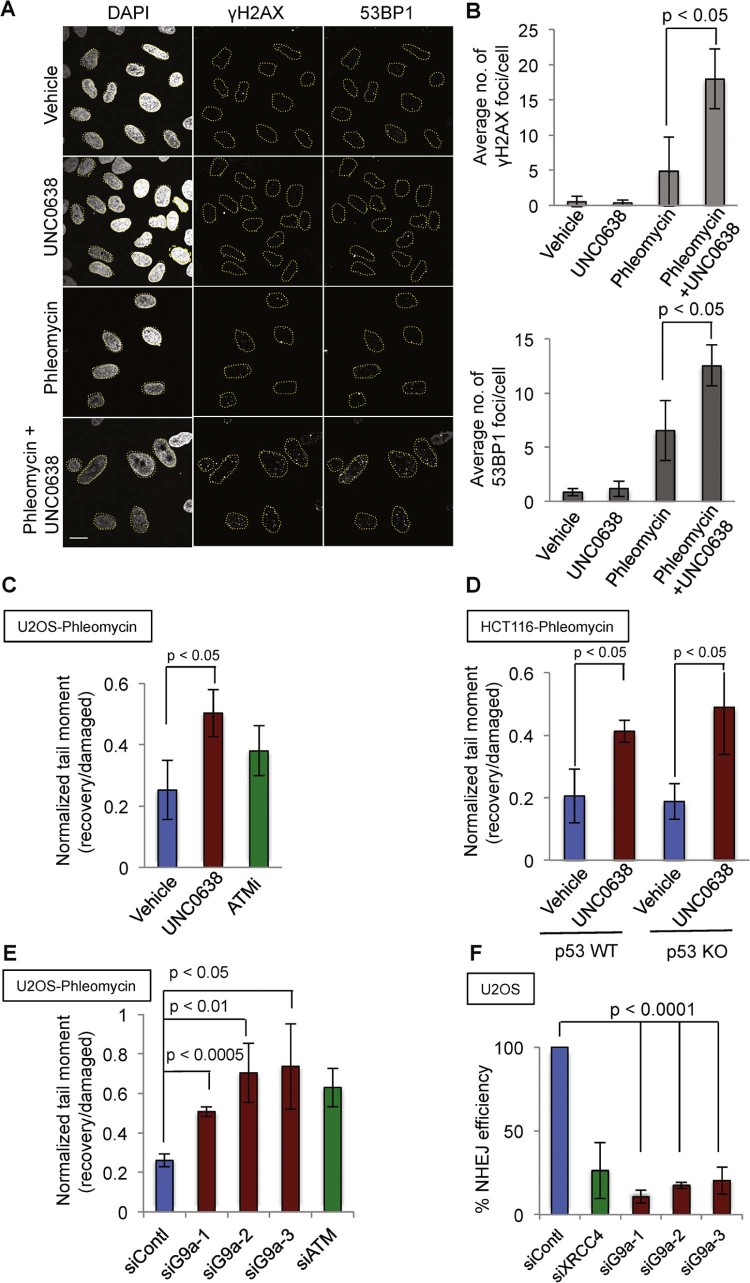
G9a inhibition impairs DNA DSB repair via NHEJ. (A) Representative immuno-fluorescent images of U2OS cells stained with antibodies recognising 53BP1, γH2AX and nuclear stain DAPI (all in grey) after indicated treatments for 4 days are shown. Dotted lines mark nuclear peripheries and the scale bar represents 10 µm. (B) Quantification of average numbers of γH2AX and 53BP1 foci per cell upon the treatments indicated in (A). Error bars correspond to SDs of three independent experiments (>100 cells were analysed per condition per experiment). Combined treatment of UNC0638 with phleomycin significantly increases the average number of γH2AX and 53BP1 foci per cell compared to phleomycin treatment alone. (C and D) DNA repair efficiencies were assayed by neutral comet assay. After the indicated treatments, U2OS and HCT116 p53 WT and KO cells were damaged with phleomycin (26 µM) for two hours (damaged), and were allowed to repair for 2 hours (recovery) after washing off the phleomycin, in the presence of indicated treatments. DSB repair efficiency was measured as the ratio of comet tail moments in recovery by damaged condition. UNC0638 treatment impaired DSB repair both in U2OS and HCT116 cells. (E) Depletion of G9a using three independent siRNAs (siG9a-1, 2, 3) impaired DSB repair upon phleomycin treatment. Depletion of ATM Kinase (siATM) served as a positive control. Comet assays were conducted as in (C). (F) Percentage efficiency of NHEJ upon depletion of G9a with three independent siRNA (siG9a-1, 2, 3) measured by random plasmid integration. Depletion of XRCC4 (siXRCC4) and control siRNA (siContl) served as positive and negative controls, respectively. Error bars correspond to SDs of three independent experiments. See also Fig. S6.